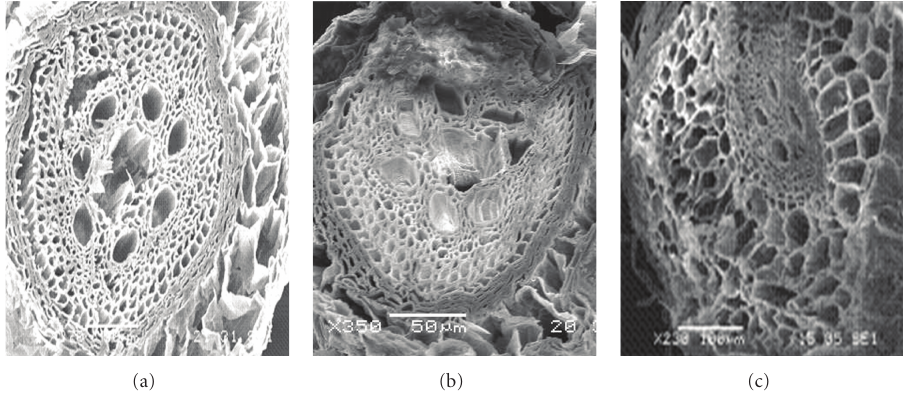
Figure 4: Scanning electron microscopy photographs showing root cortical tissue of Zoysia japonica under (a) 0, (b) 24, and (c) 48 dSm − 1 .